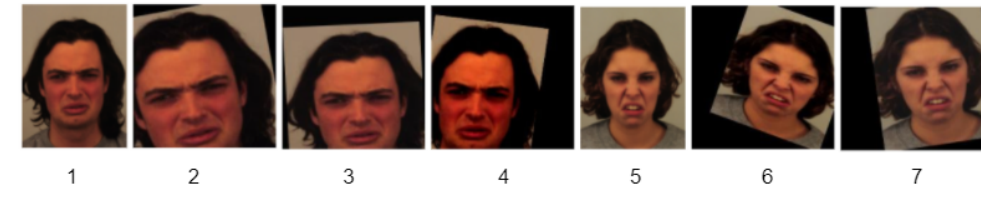
Figure 8. Data augmentation examples for disgust